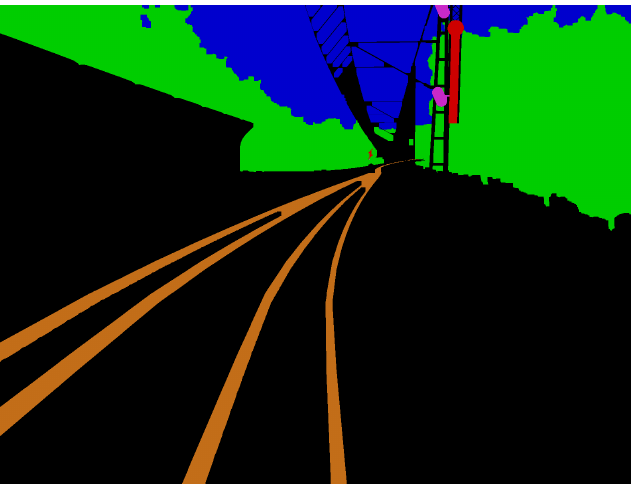
Figure 2. Example of an annotated